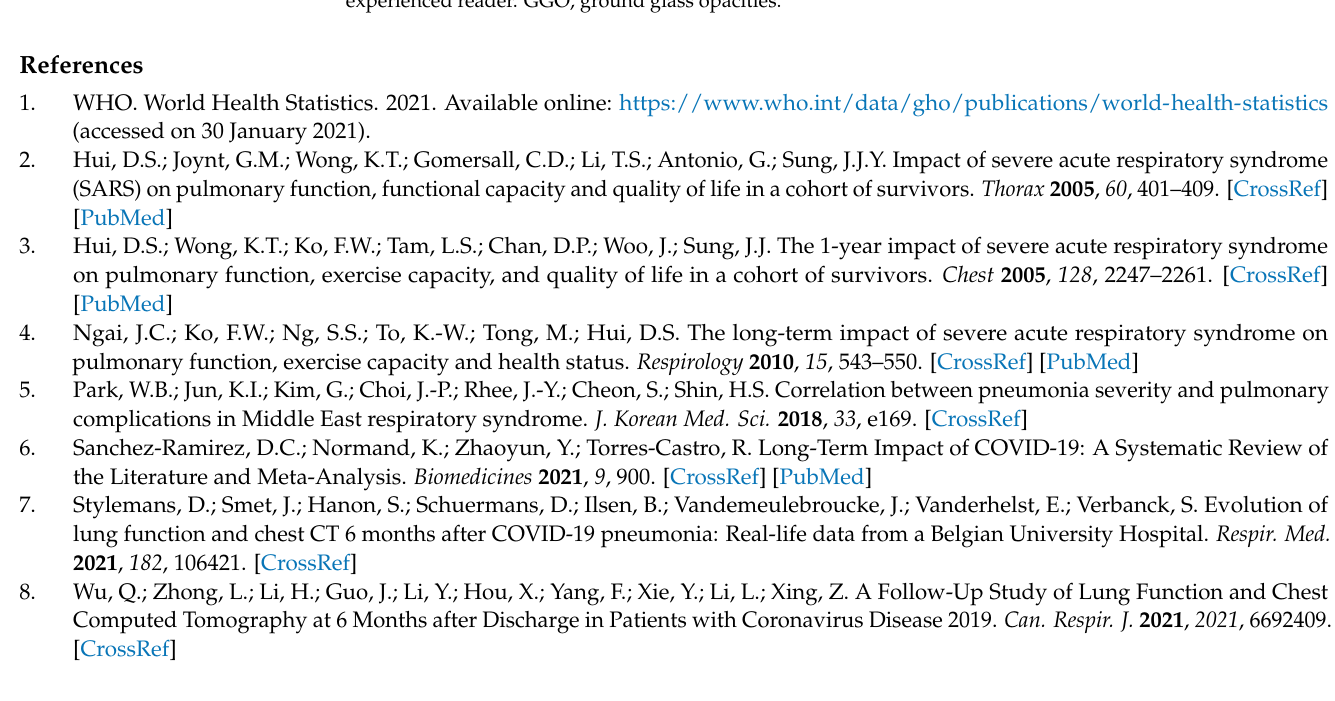
Table A1. Inter-rater agreement in the assessment of CT patterns and individual findings. Reader 1 (GB) is the most unexperienced reader, Reader 2 (LS) has intermediate experience, while Reader 3 (NS) is the most experienced reader. GGO, ground glass